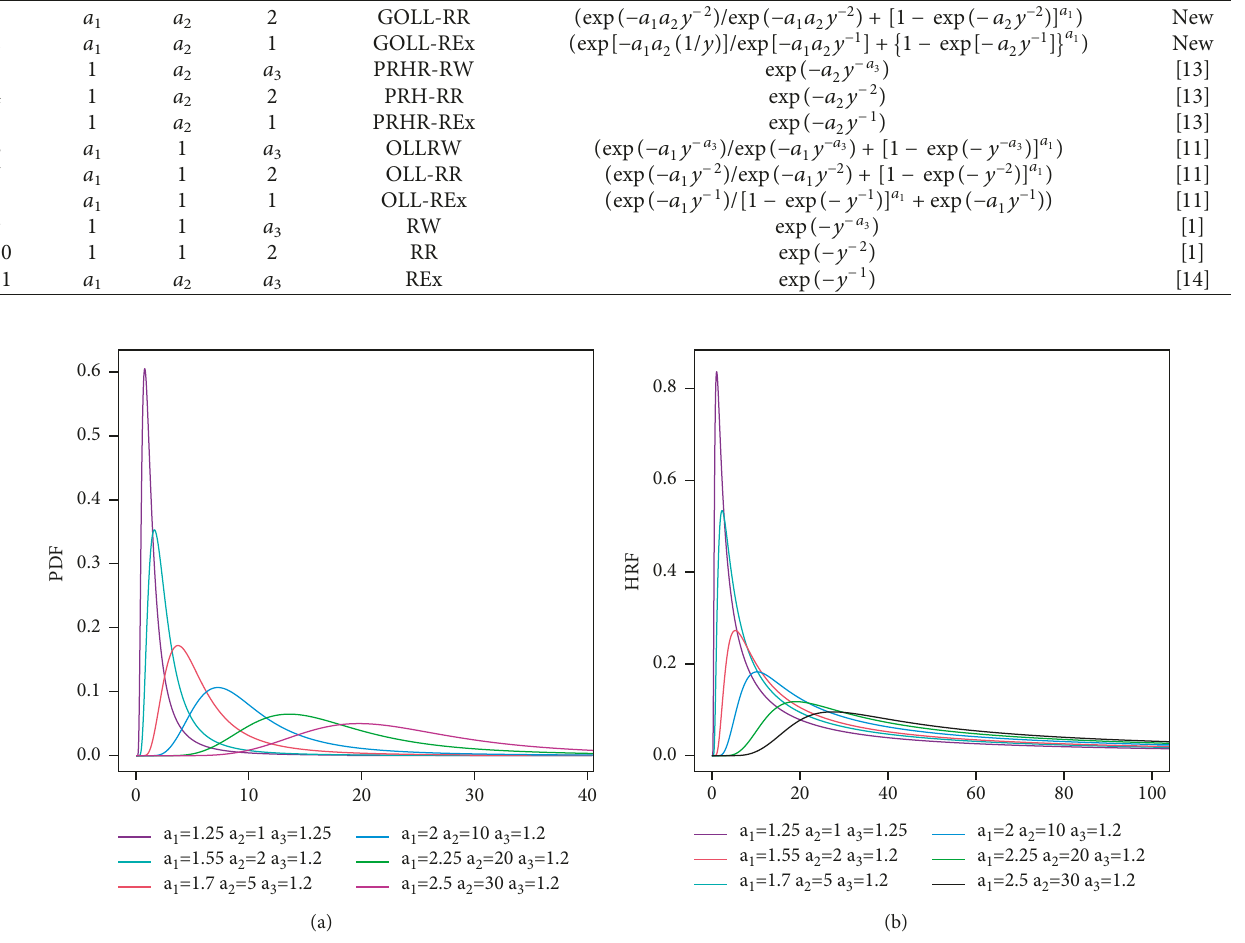
Figure 1: Plots of the GOLLRW PDF (a) and GOLLRW HRF (b).